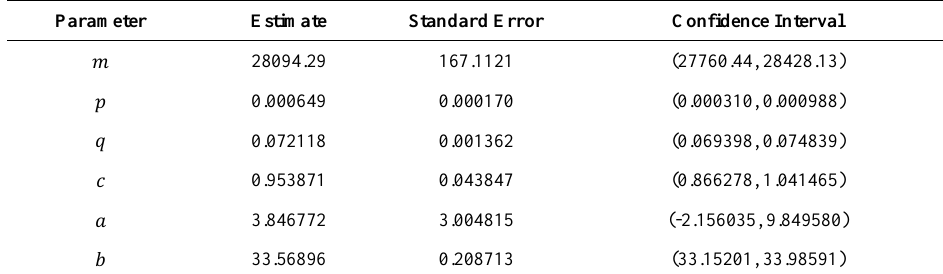
Table A25. Emilia–Romagna. Estimates, asymptotic standard errors and 95% mCIs for the parameters of the GBM 𝑹𝑬𝑪𝑻 (4)+(5).